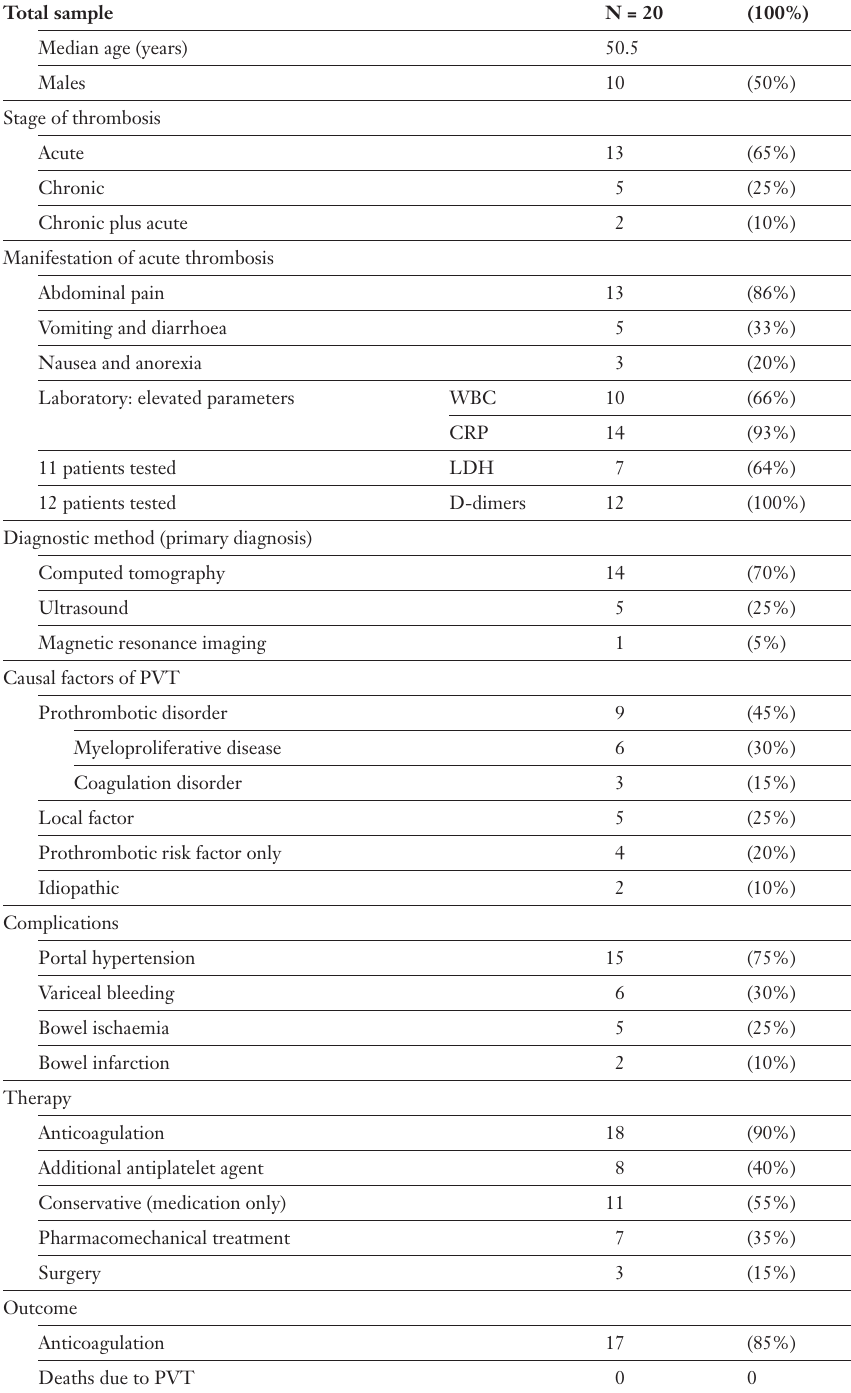
Table 1 Main characteristics of study